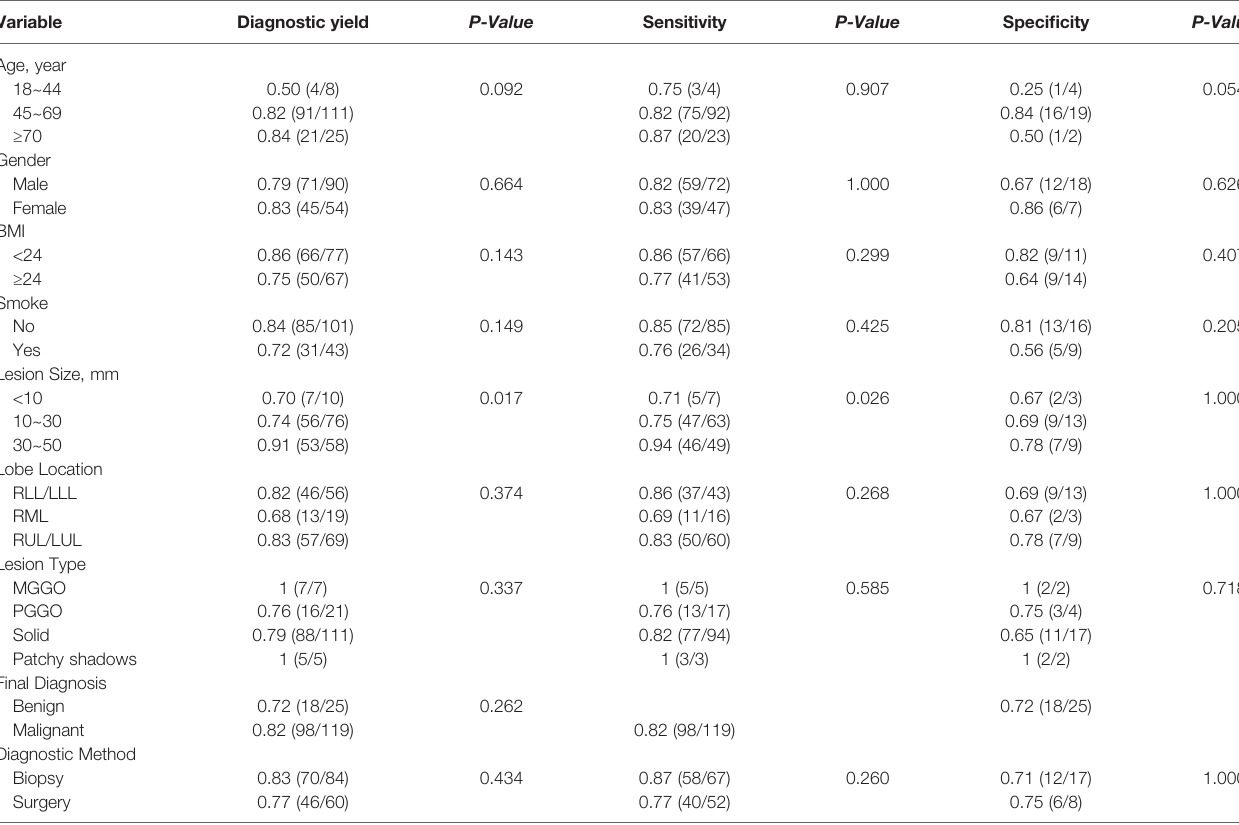
TABLE 3 | Diagnostic yield in the analytical validation dataset by different